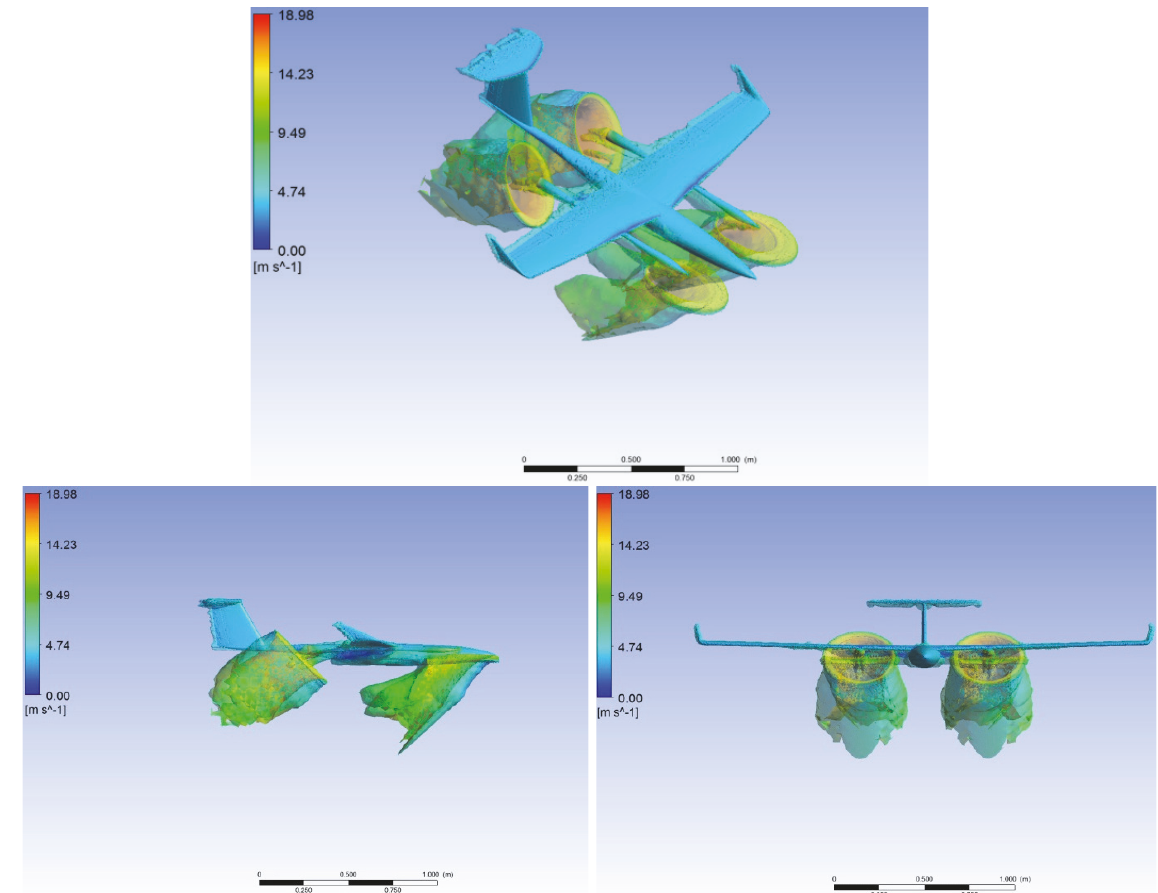
Figure 14: Isosurface of vorticity (Re = 77 000) for 100 s −1 (the color of isosurface represents wind velocity) for AoA=0 ∘ ; tilt of the rear rotor nacelles 𝛿 𝑡 = 45 ∘